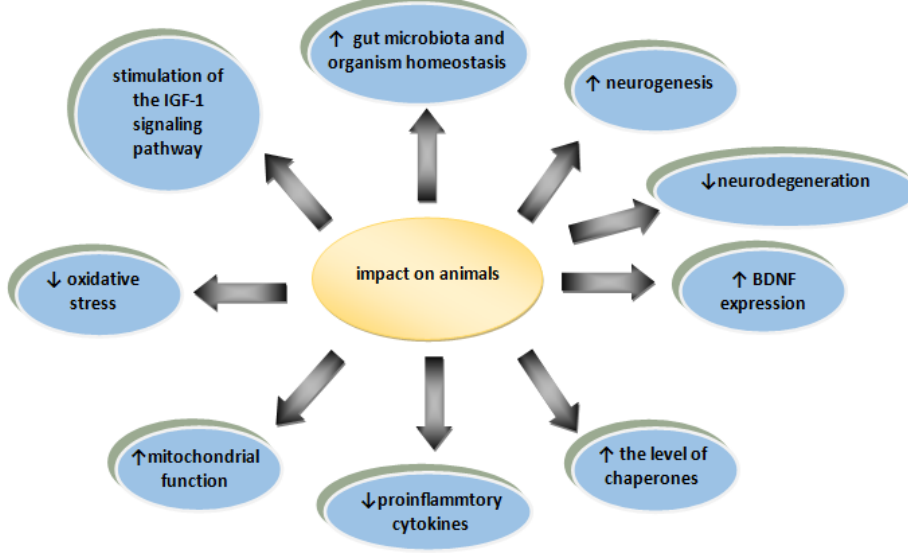
Fig. 2. The impact of DR and IF on cells and tissues based on an animal